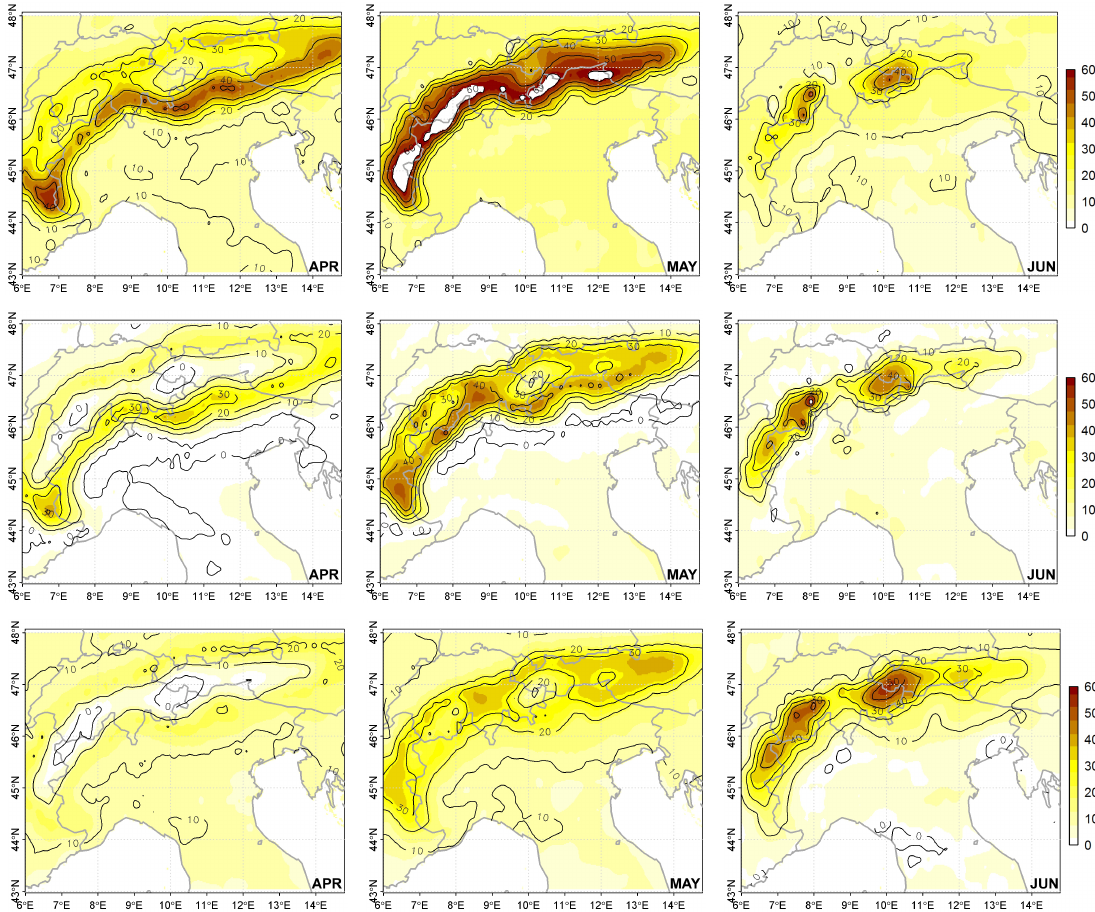
Figure 7. Differences between FC A 2 and the RC in net radiation ( ∆ NR; top panels ), sensible heat flux ( ∆ SHF; middle panels ), and latent heat flux ( ∆ LHF, i.e., evapotranspiration; bottom panels ) for April, May, and June. Units are W m − 2